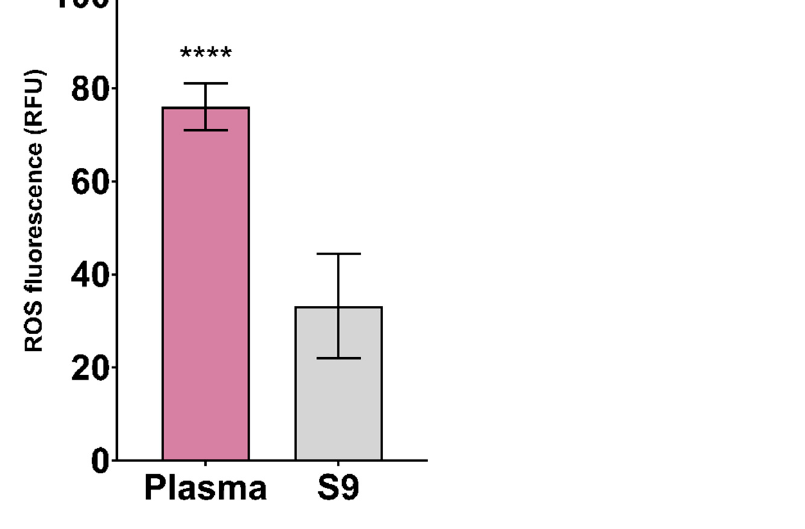
CES absorbance; Figure S4. GST absorbance; Figure S5. GR absorbance; Figure S6. CellTracker TM Green CMFDA dye for GSH detection; Figure S7. CM-H 2 DCFDA dye for ROS detection.